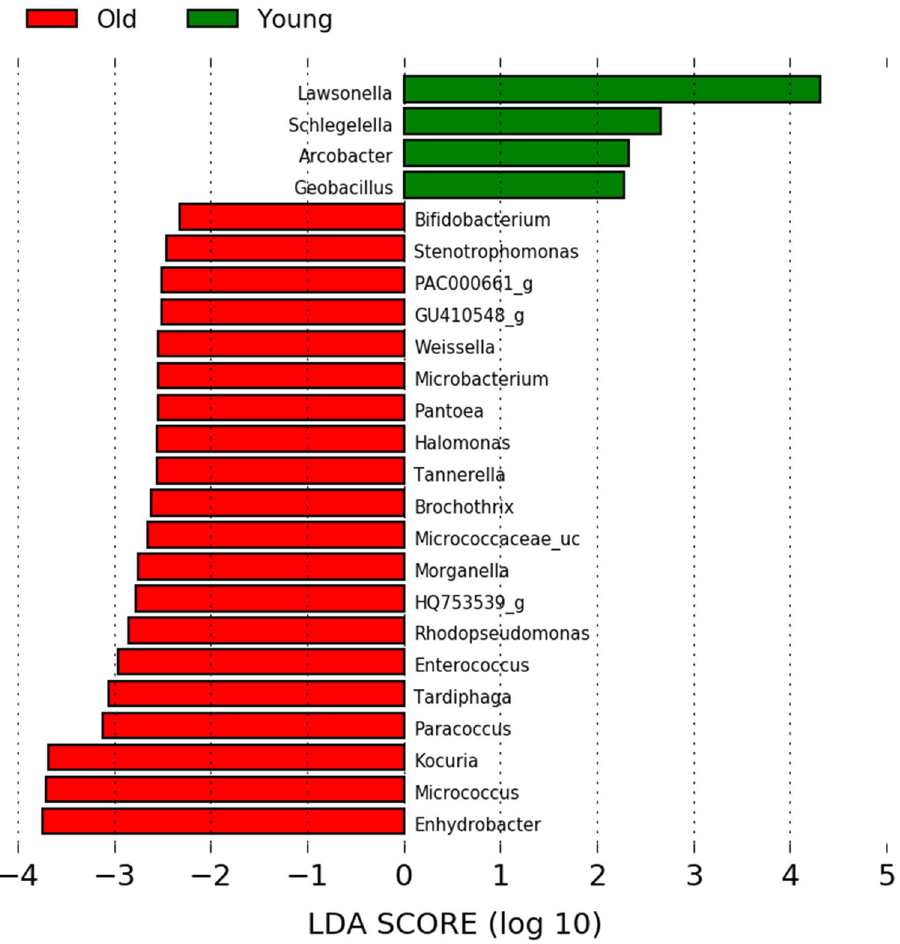
Figure 7. Taxonomic differences from LEfSe analysis. Linear discriminative analysis (LDA) scores are calculated at the genus level between the younger group (green, young) and the older group (red,